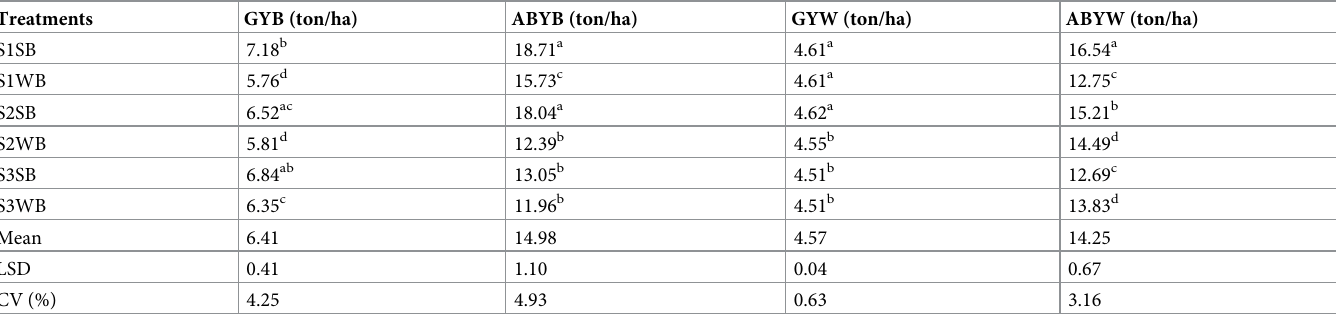
Table 5. Model scenarios for maize grain and aboveground biomass yield in Aba Gerima catchment.